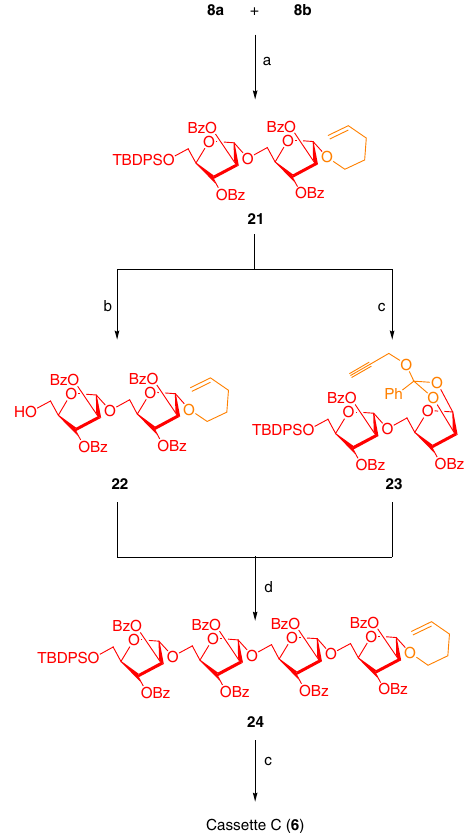
Figure 6 | Synthesis of cassette C. Reagents and conditions: (a) AuCl 3 (7mol%), CH 2 Cl 2 , 4Å MS powder, 25 (cid:2) C, 2h, 84%. (b) Py (cid:2) HF, THF:Py (5:1), 0 (cid:2) C - 25 (cid:2) C, 4h, 95%. (c) Br 2 , CH 2 Cl 2 , 4Å MS powder, 10min, 0 (cid:2) C followed by propargyl alcohol, 2,6-lutidine, tetrabutylammonium